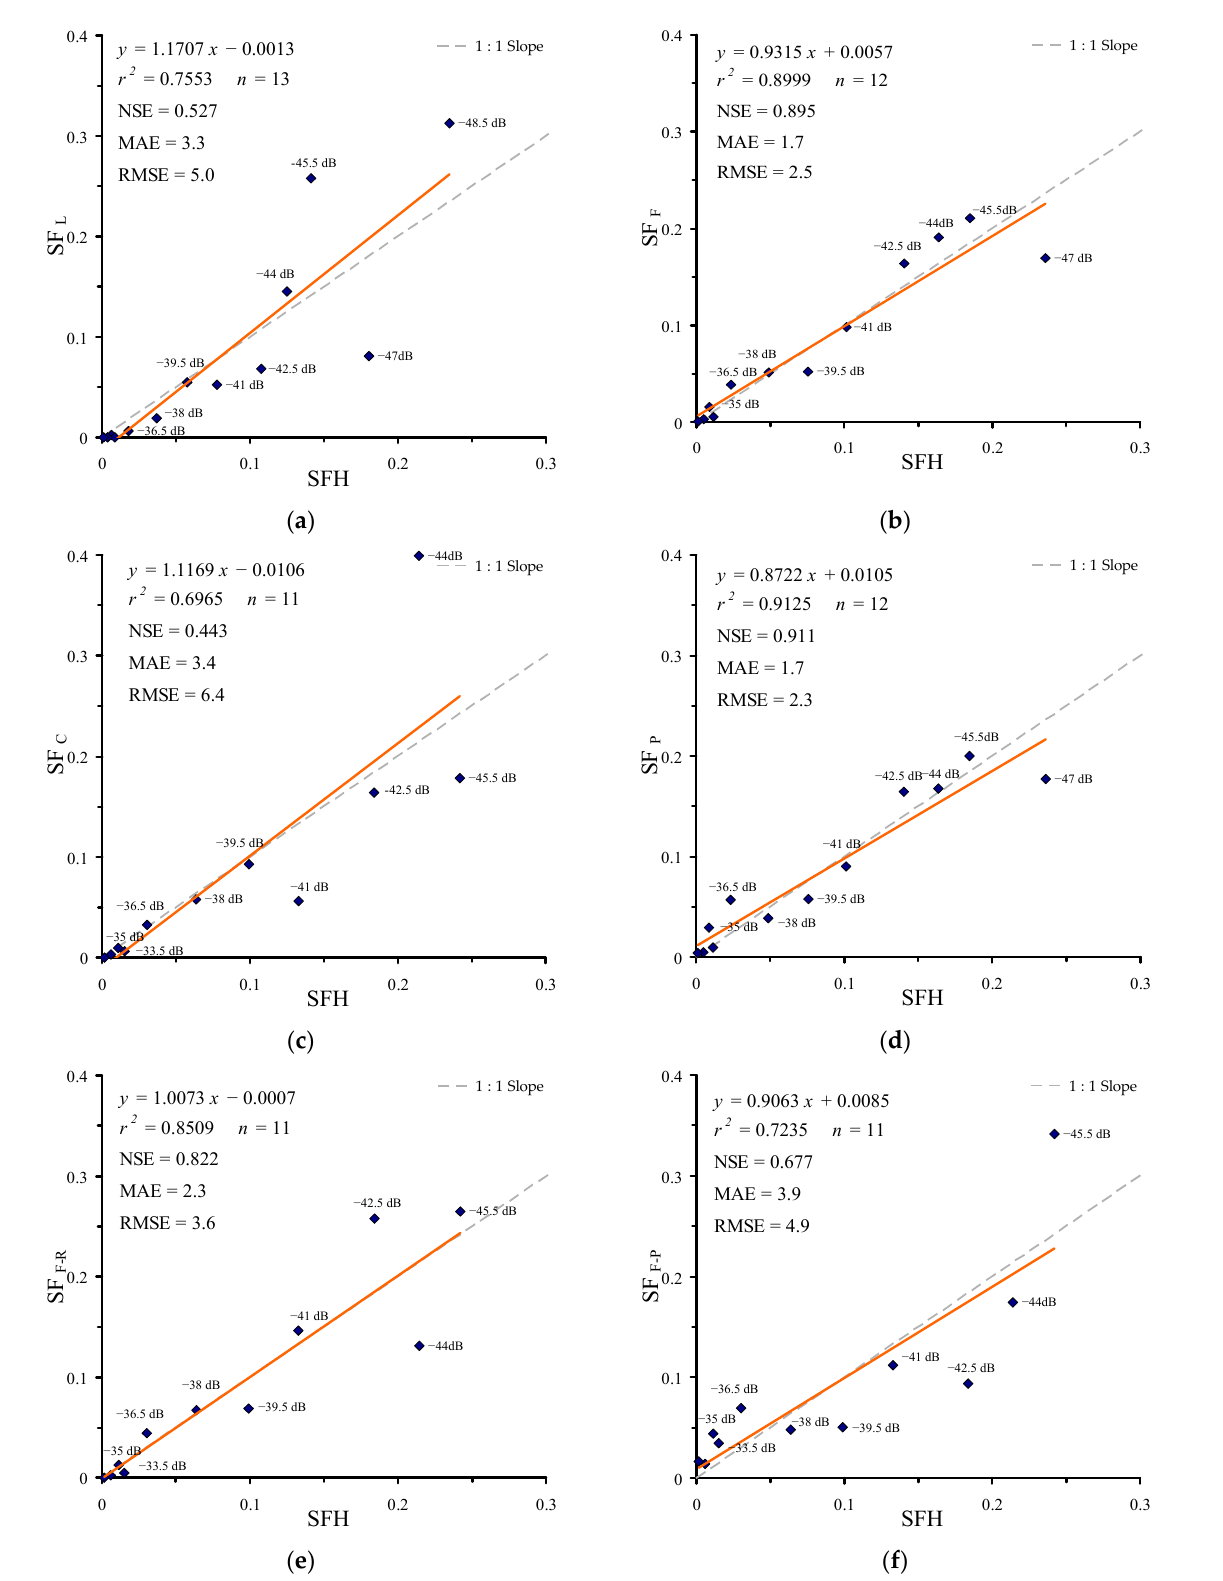
Figure 6. Regression between the relative proportion of fish caught with Nordic multimesh gillnets ( SF ) assigned to total length ( TL ) classes (marked with an orange line) according to various TS – TL regressions from the literature, and the relative proportion of hydroacoustically identified fish ( SFH ). ( a – f ) as in Figure 4.